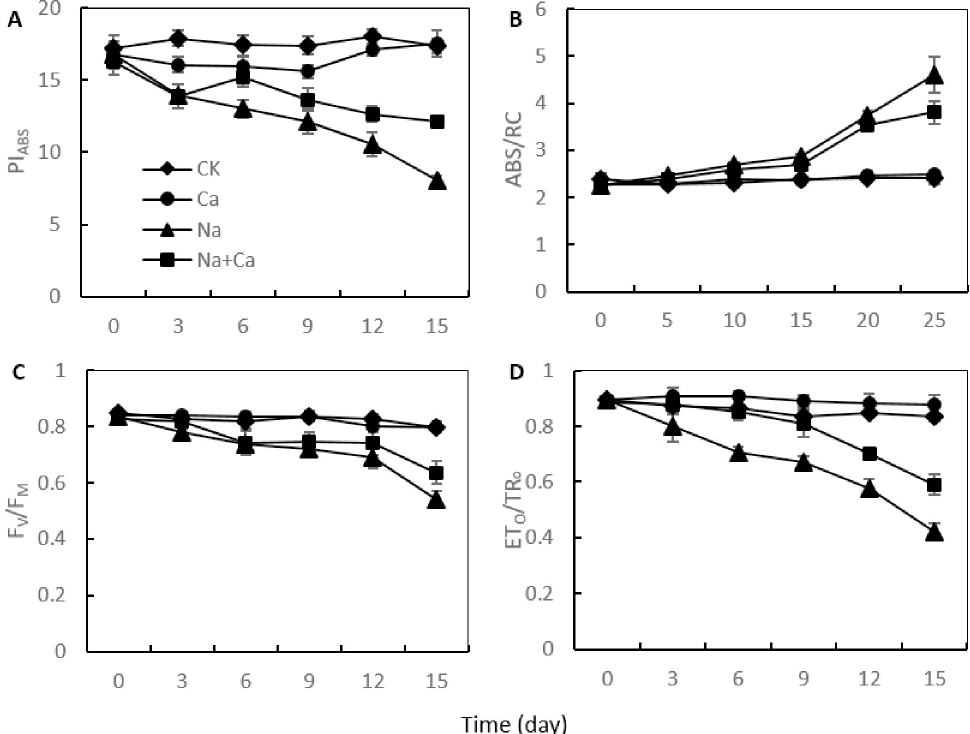
Fig 4. T The parameters of PF OJIP transients of oat leaves in the NaCl treatment and NaCl treatment with CaCl 2 amendment on the day of NaCl stress and on days 3, 6, 9, 12, and 15 of NaCl stress. (A) PI ABS , performance index. (B) ABS/RC, absorption of antenna chlorophyll per PSII reaction center. (C) F V /F M , potential maximum photosynthetic capacity. (D) ET O /TR O , efficiency of electron movement. Each parameter is the average of 3